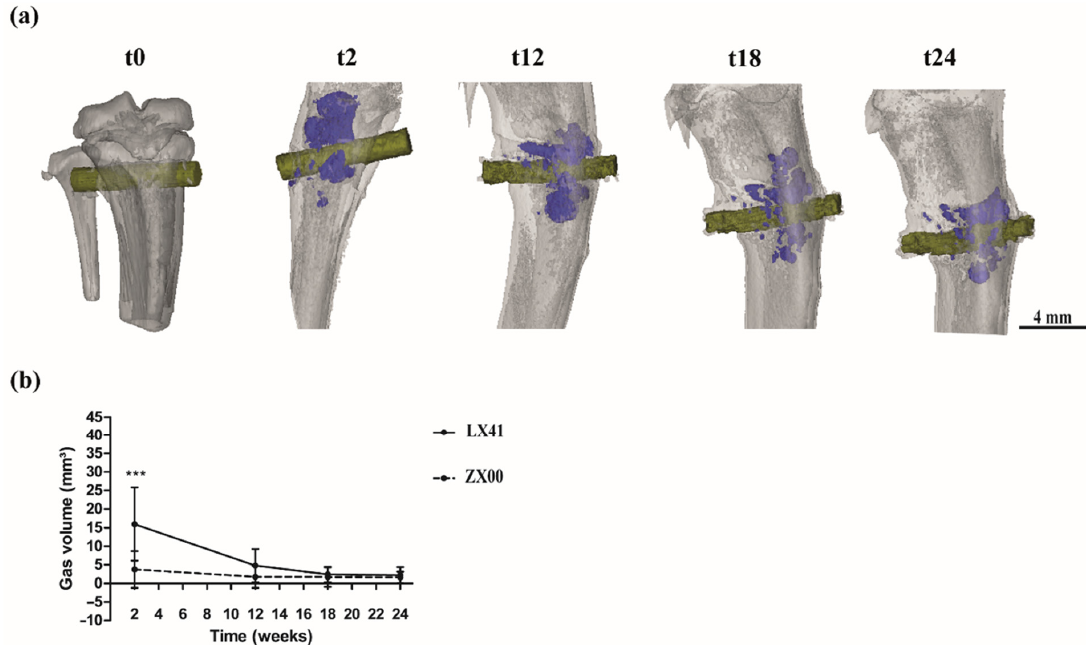
Figure 6. ( a ) For illustrative purposes, one LX41 pin was 3D ‐ reconstructed from the μ CT data via Mimics 23.0. at 0, 2, 12, 18 and 24 weeks upon implantation. ( b ) Comparison of hydrogen gas evolution between LX41 and ZX00 over the entire study period of 24 weeks (data for ZX00 adapted from [24]). The volume of hydrogen gas generated by LX41 and ZX00 implants was evaluated 2, 12, 18 and 24 weeks after implantation. The data are shown as a mean ± SD. *** p ‐ value < 0.001. To evaluate bone ‐ to ‐ implant contact, bone morphology and any local adverse events caused by LX41 implantation, bones were excised 24 weeks after implantation, dehy ‐ drated and embedded in Technovit 9100 New. The region of interest was stained with Levai–Laczko [25] solution (Figure 7). For descriptive histological analysis, three bones with respective implants were used. The overview (Figure 7a,c) showed an intact bone marrow cavity (mc), despite the presence of gas cavities (gc). In the bone tissue area, the pin was almost surrounded by a newly formed bone layer in close contact (green arrow head). The bone layer extended even into the medullary cavity (Figure 7d,f) and was in close contact to the LX41 pin that indicates a good osseointegration. Bone formation still continued as demonstrated in Figure 7f. The magnification of region of interest (Figure 7f, orange rectangle) highlights new dark pink colored bone (nb) with larger cell nuclei in close proximity to the LX41 pin (nb). The partly visible grey striae were an artefact that occurred when cutting the samples and therefore have no significance for the histological evaluation (orange asterisks). Addition ‐ ally, degradation products were observable at the interface to bone (Figure 7b, dl). Gas bubbles with brown cell detritus were histologically visible adjacent to the pin (Figure 7f, mc). We additionally observed dark blue degradation clods at the tip of the LX41 pin (Figure 7f, dm) and newly formed bone to the LX41 pin (pinkish area; green arrow heads). The light pinkish area further away from the pin contained small cell nuclei indicating older bone (Figure 7d, b). Figure 7d highlights dark blue crystalline degradation products located at the pin end, which were released and fragmented during the degradation process (dm).